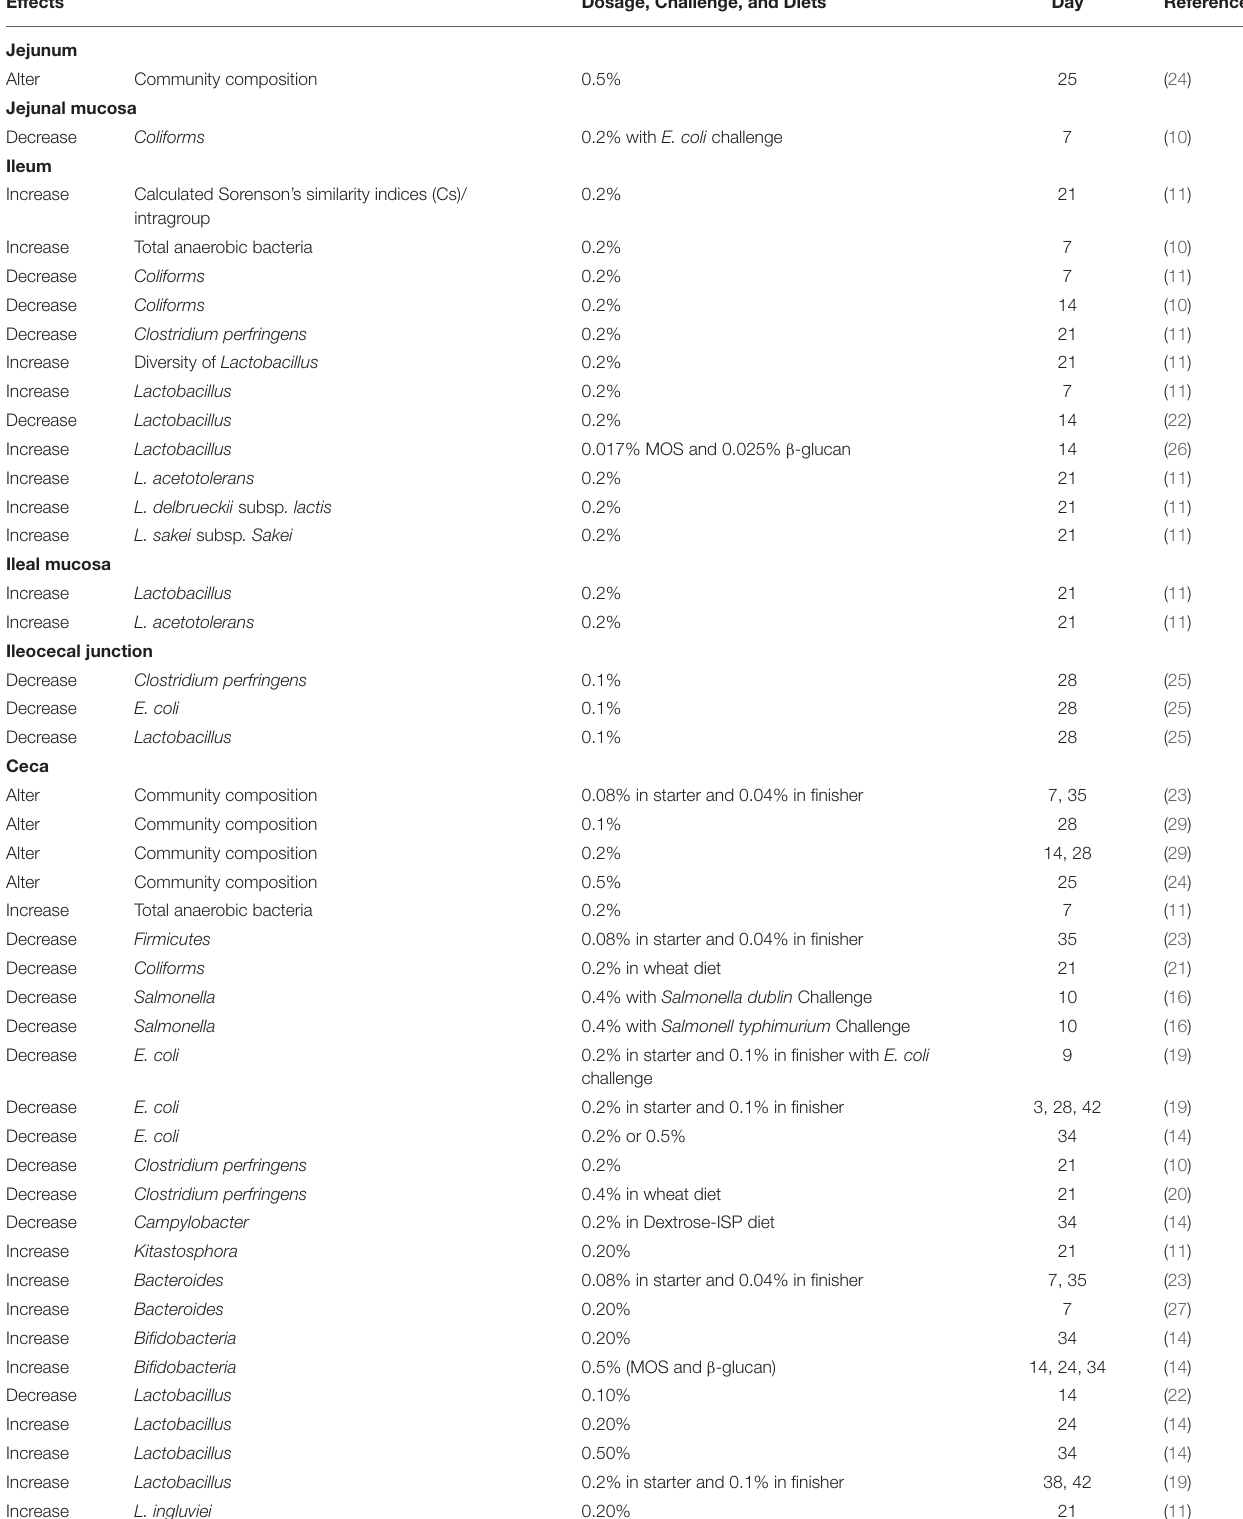
TABLE 1 | Effects of mannan oligosaccharides on intestinal microbiota of broilers.